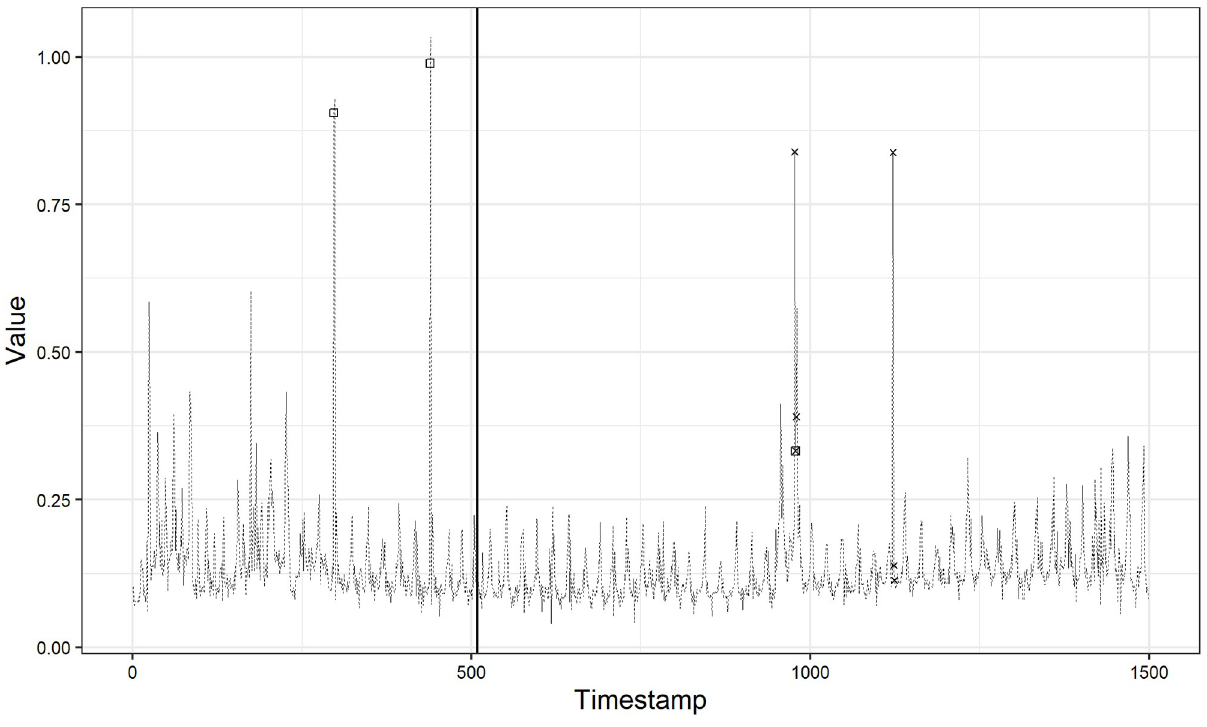
Fig 7. Anomaly detection result on